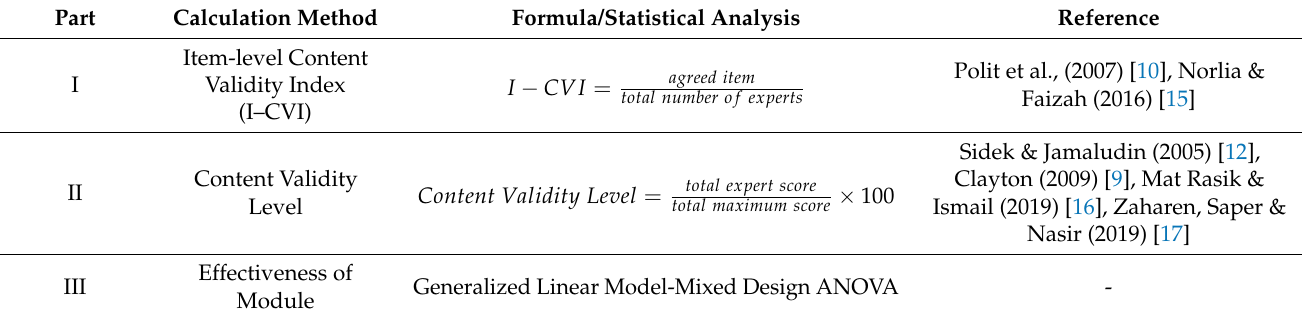
Table 1. Content validity calculation and effectiveness statistical analysis.